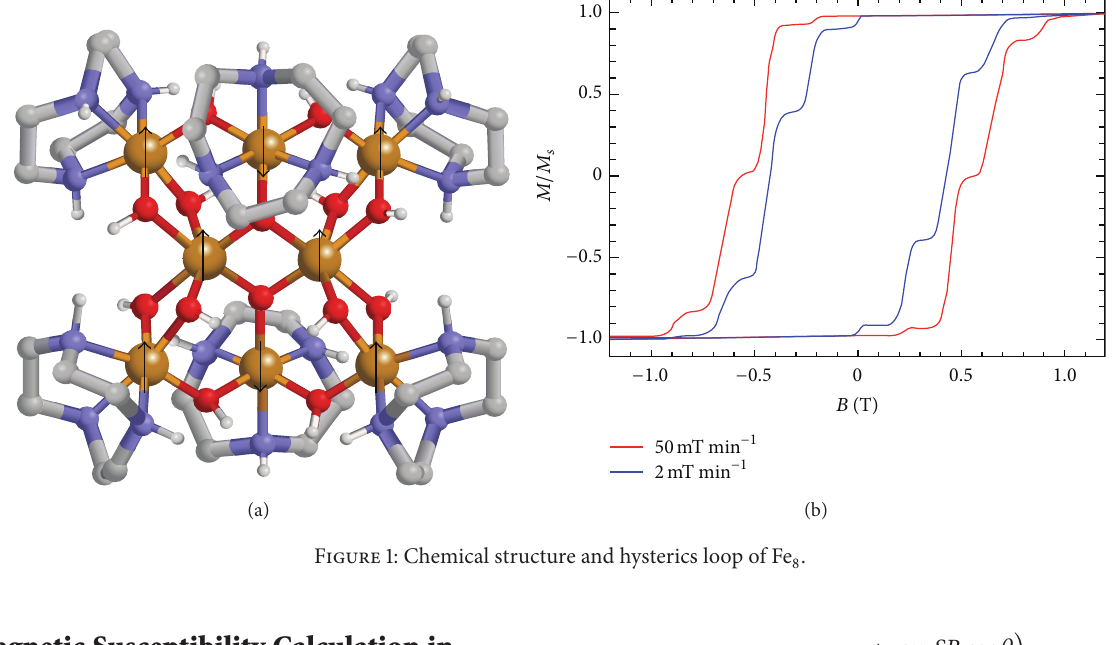
Figure 1: Chemical structure and hysterics loop of Fe 8